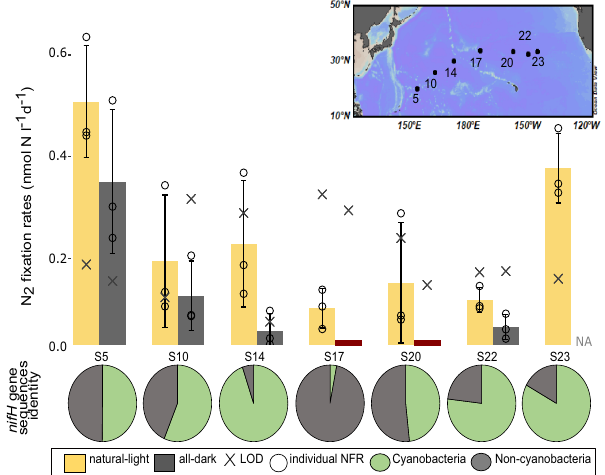
Fig. 1 | N 2 fi xation rates and community composition by station. Map inset shows stations (S) sampled across the North Paci fi c Subtropical Gyre. Bar chart shows community N 2 fi xation rates averages under natural-light (yellow) and all- dark (dark grey) conditions derived from biological triplicates. Individual N 2 fi xa- tion rates values are shown as black circles for each station and light treatment. Errorbarsarethestandarddeviationsoftheaverages( n =3).Thelimitofdetection (LOD) for the N 2 fi xation rates are shown with an X. Stations where the X is above theaveragearebelowtheLODbutabovetheminimumquanti fi ablerate(MQR),all- dark values at S17 and S20 were below LOD and MQR (red), no data were available for S23 all-dark incubation. The lower pie charts show the relative proportion of cyanobacterial(green)andNCD (lightgrey) nifH sequencesateachstation.Source data are provided as a Source Data fi